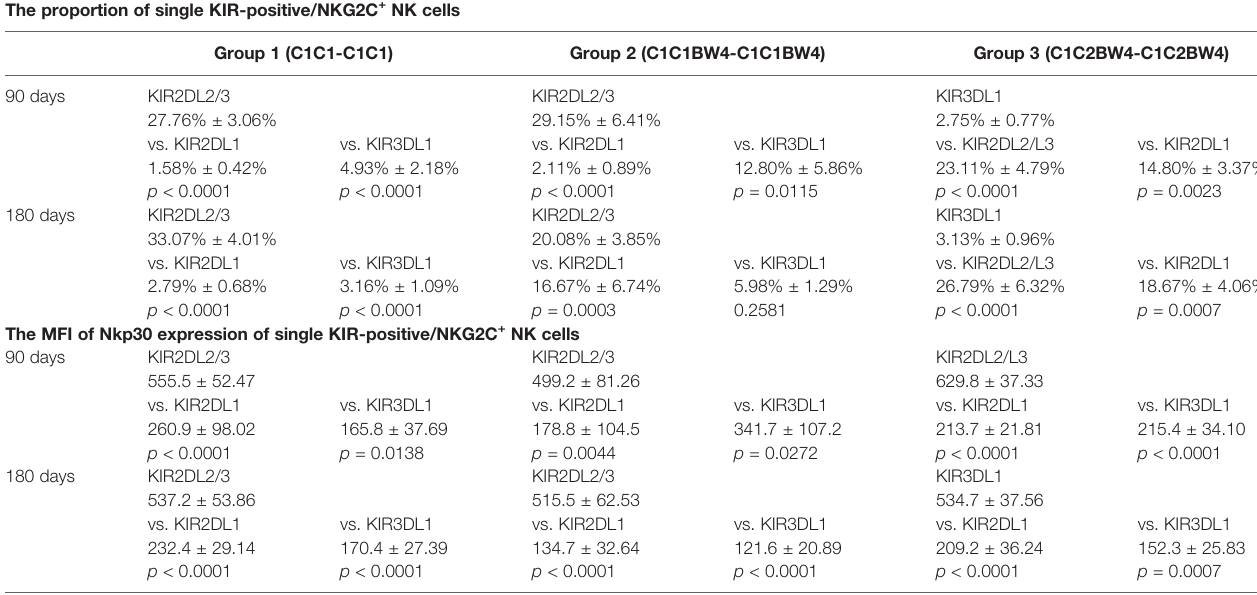
TABLE 3 | The proportion and the MFI of NKp30 expression of single KIR positive/NKG2C + NK cells. The proportion of single KIR-positive/NKG2C + NK